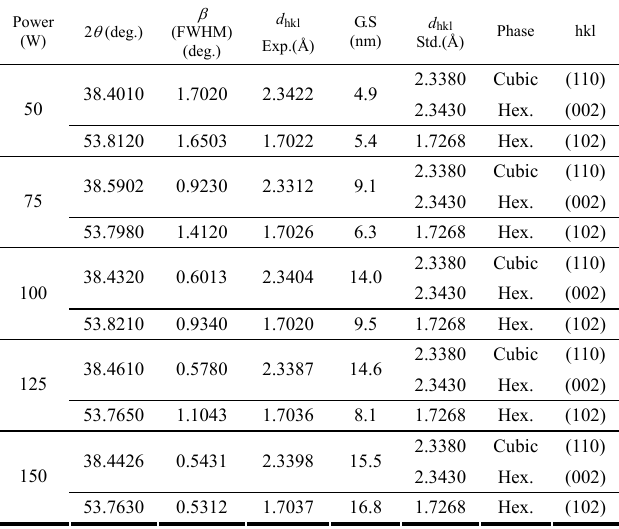
Table 1 Comparison between the Exp. and Std. the values of d hkl for the (Ti6Al4V) peaks shown in XRD for different RF powers on a glass